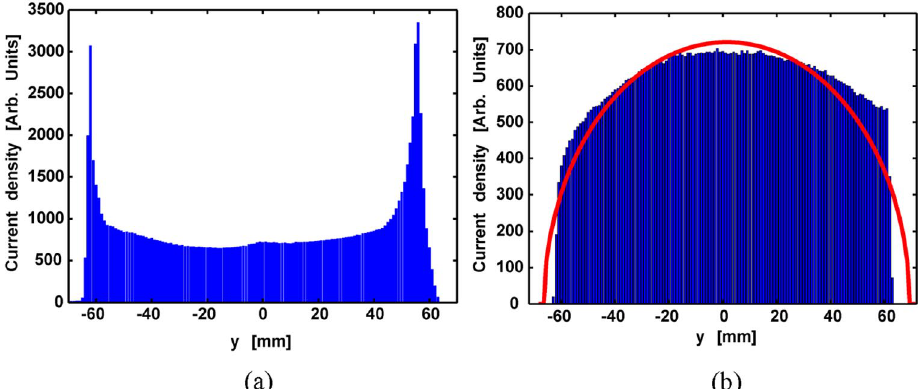
)], (b) after final optimization of 0